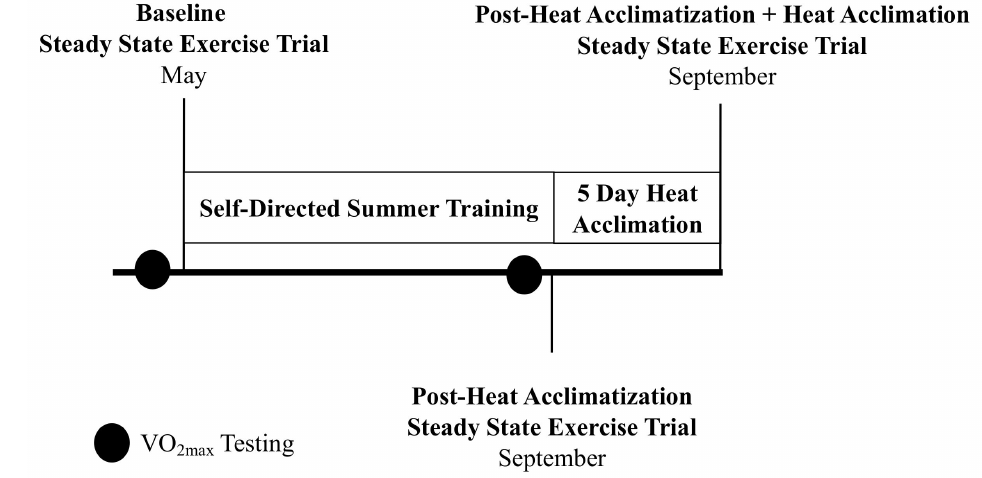
Figure 1. Study timeline. Baseline, post-heat acclimatization, and post-heat